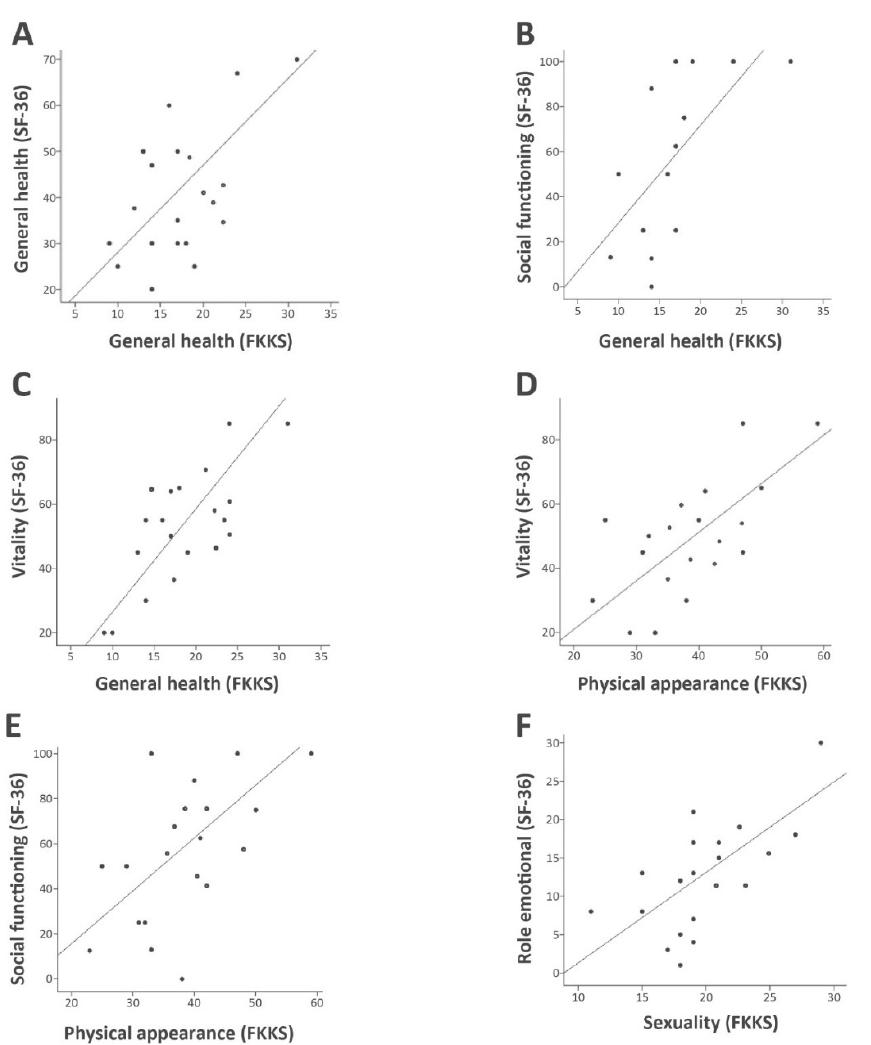
Figure3. CorrelationsofSF-36andFKKSsubscales(Pearsoncorrelation, p < 0.05, n = 20). ( A )Correlation Figure 3. Correlations of SF-36 and FKKS subscales (Pearson correlation, p < 0.05, n = 20). ( A ) of self-perception of general health with general health (r 2 = 0.41); ( B ) Correlation of self-perception of Correlation of self-perception of general health with general health (r² = 0.41); ( B ) Correlation of self- general health with social functioning (r 2 = 0.42); ( C ) Correlation of self perception of general health with vitality (r 2 = 0.65); ( D ) Correlation of physical appearance with vitality (r 2 = 0.49); ( E ) Correlation perception of general health with social functioning (r² = 0.42); ( C ) Correlation of self perception of of physical appearance with social functioning (r 2 = 0.42); ( F ) Correlation of sexuality with emotional general health with vitality (r² = 0.65); ( D ) Correlation of physical appearance with vitality (r² = 0.49); role functioning (r 2 =